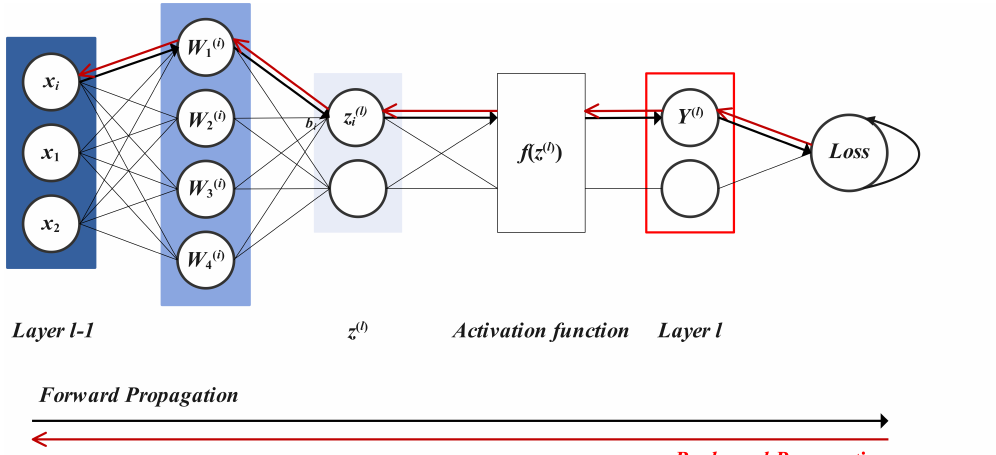
Figure 6. Forward propagation and error backpropagation.